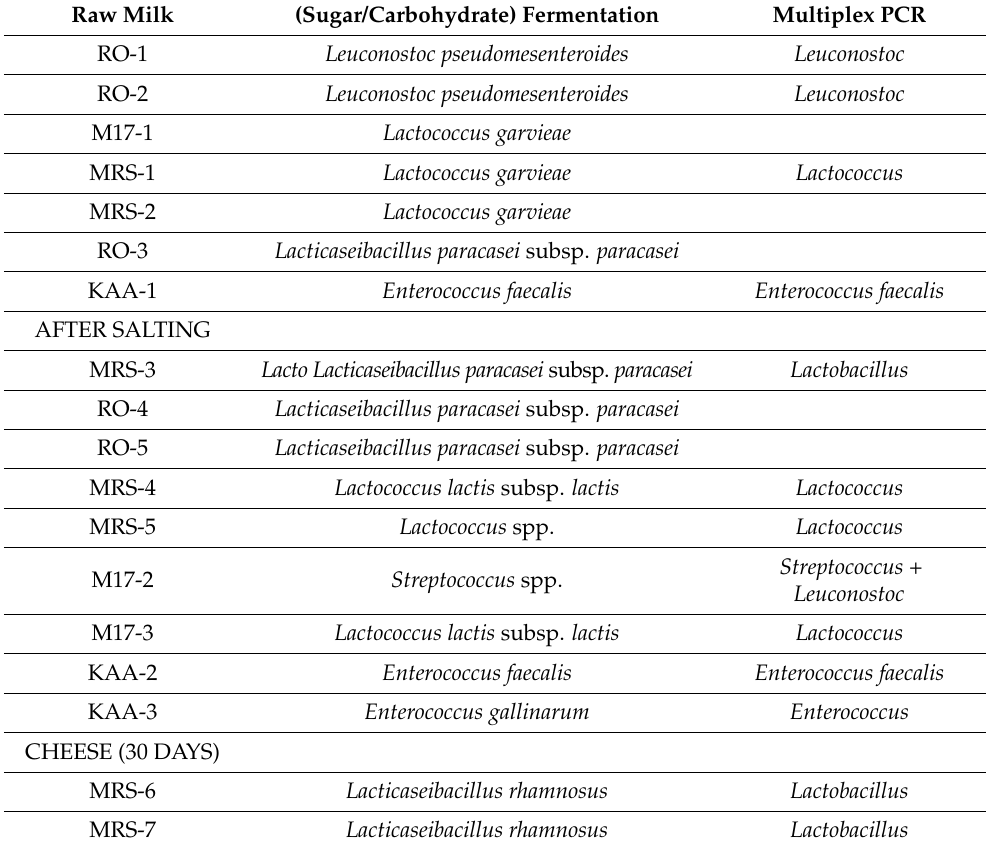
Table 4. Molecular identification of strains .